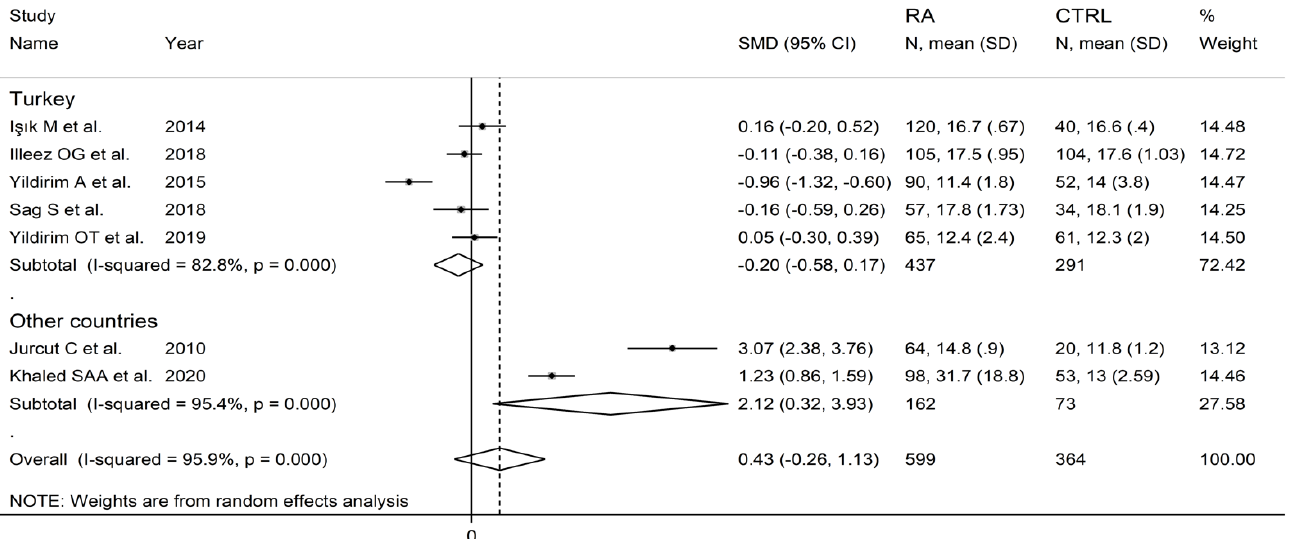
Figure 10. Forest plot of studies examining the platelet distribution width in patients with rheuma- toid arthritis and healthy controls according to study design.